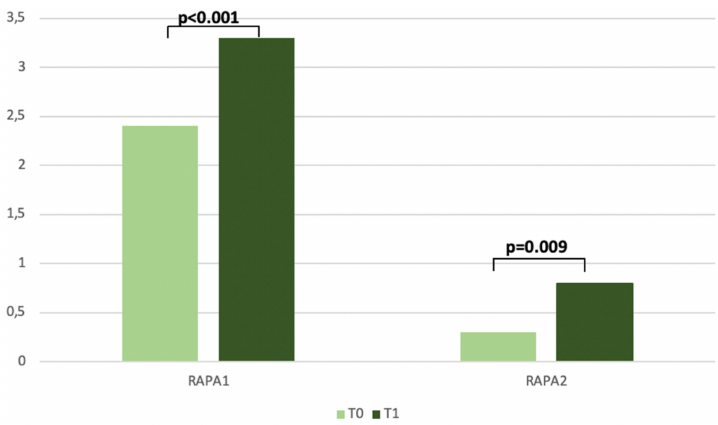
Figure 5. Changes in Rapid Assessment of Physical Activity from T0 to